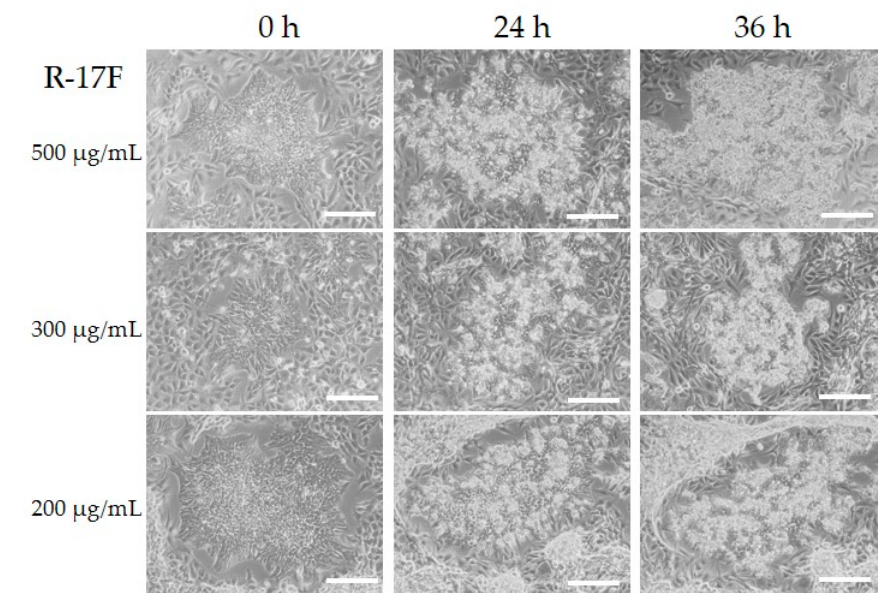
Figure 5. Images of iPSC colonies and chondrocytes (C28/I2) after treatment with R-17F at various concentrations. iPSCs and chondrocytes (C28/I2) were cultured for 3 days, followed by adding R-17F at the concentration of 200–500 µg/mL. All cells were monitored under a microscope. Scale bar = 500 µm.